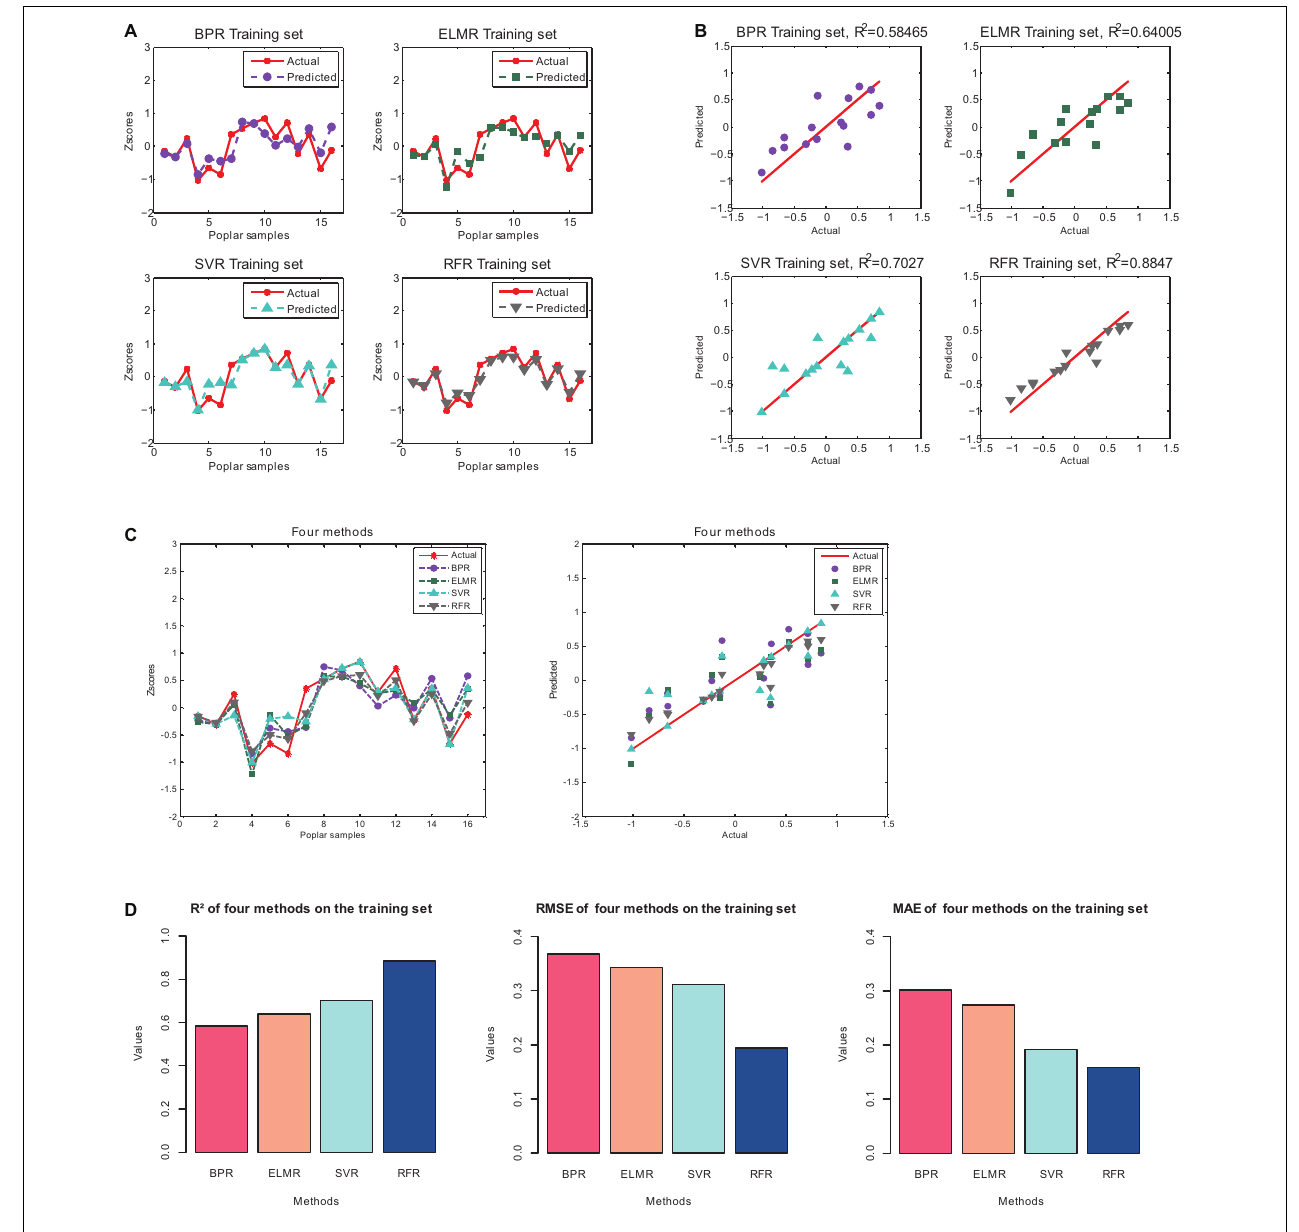
FIGURE 6 | The regression results of the four machine learning methods on the training set. (A) Results of Predicted. (B) Predicted and actual value. (C) Comparison of results of four methods. (D) The R 2 , RMSE and MAE of the four machine learning methods on the training set.